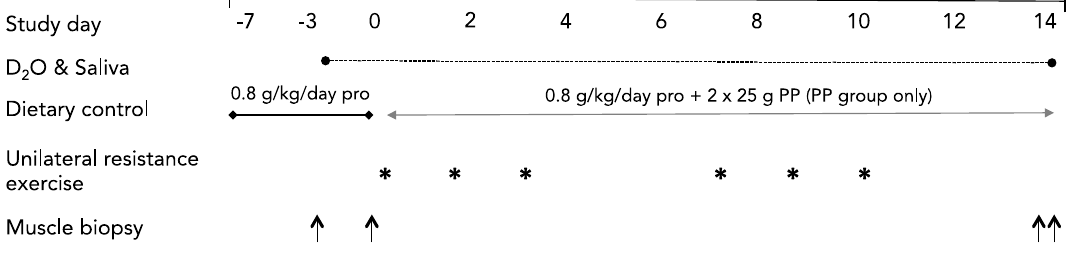
Figure 1. Study schematic. PP, potato protein. * indicates a unilateral resistance exercise session. ↑ indicates one muscle biopsy